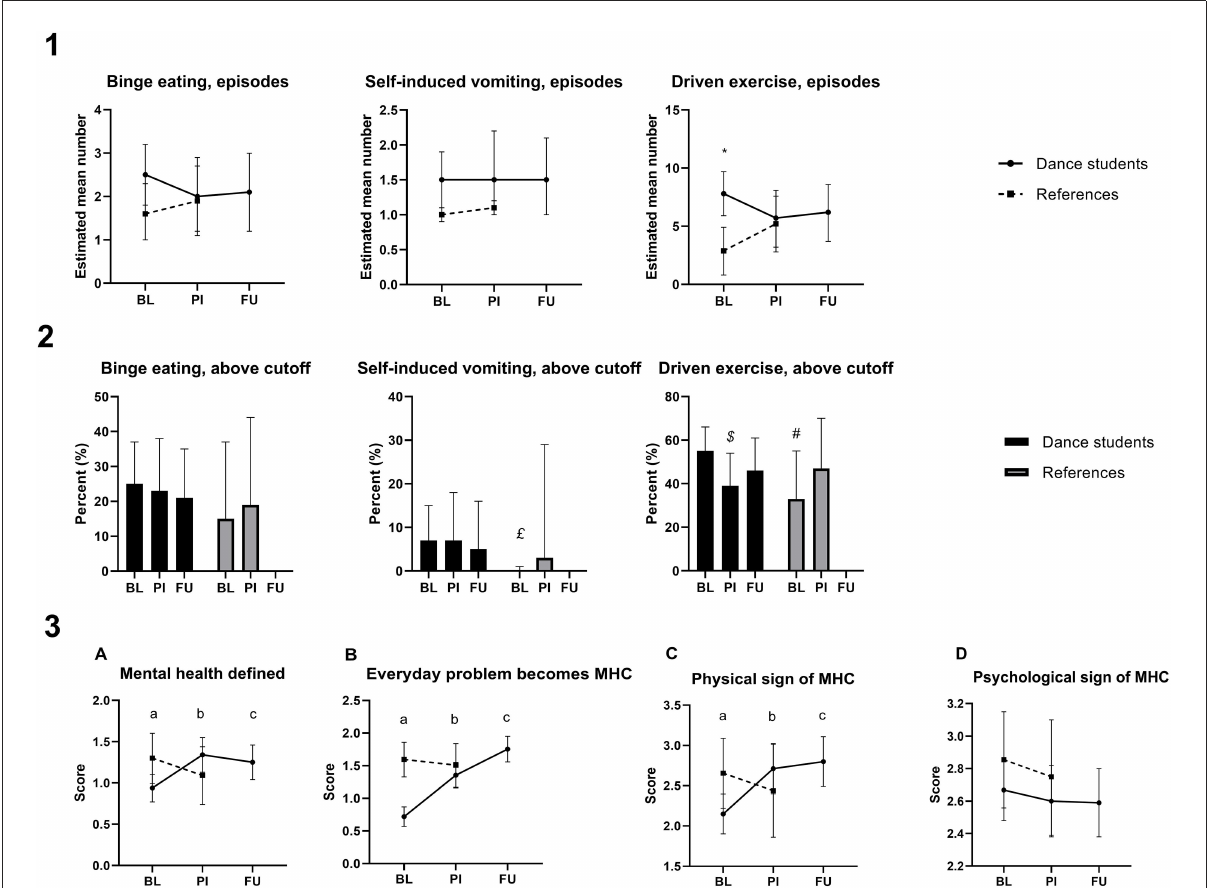
FIGURE2 Health behavior and health literacy. The estimated mean (CI 99%) number of episodes with binge-eating and purging among dance students and references across time (Row 1), and the percentage above the respective clinical cutoffs (Row 2). Row 3 illustrates results from mental health literacy questions: “What is mental health to you?” (A) , “When does an everyday problem become a mental health challenge?” (B) , “Mention three physical signs of mental health challenges” (C) , and “Mention three psychological signs of mental health challenges” (D) . BL, baseline; PI, post-intervention; FU, 6 months follow-up; MHC, mental health challenge; *significant between-group difference (mean (CI 99%) differences of 4.9 (1.3, 8.6), g = 0.64, p = 0.001; £significant between-group difference (mean (CI 99%) differences of 6.9 (1.3, 12.3), g = 4.09, p = 0.002; $ significant within-group change (mean (CI 99%) change of 15.8 ( − 0.5, 32.0), g = 1.77, p = 0.016; # significant between-group difference (mean (CI 99%) differences of 21.4 ( − 1.5, 44.4), g = 12.9, p = 0.016. a significant difference between groups; b significant change from BI among dance students; c significant change from BI among dance